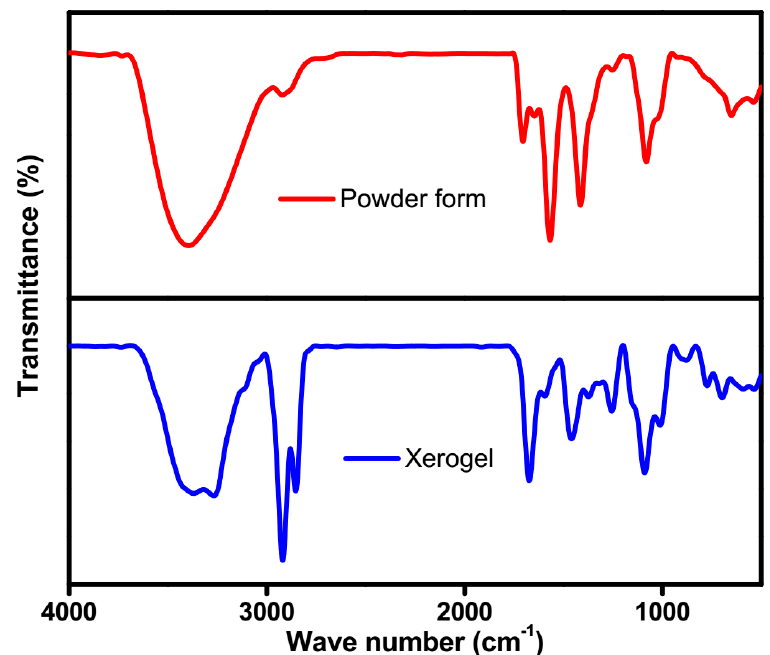
Figure 4. FTIR spectra of compound 5b in powder form ( red ) and xerogel ( blue ).